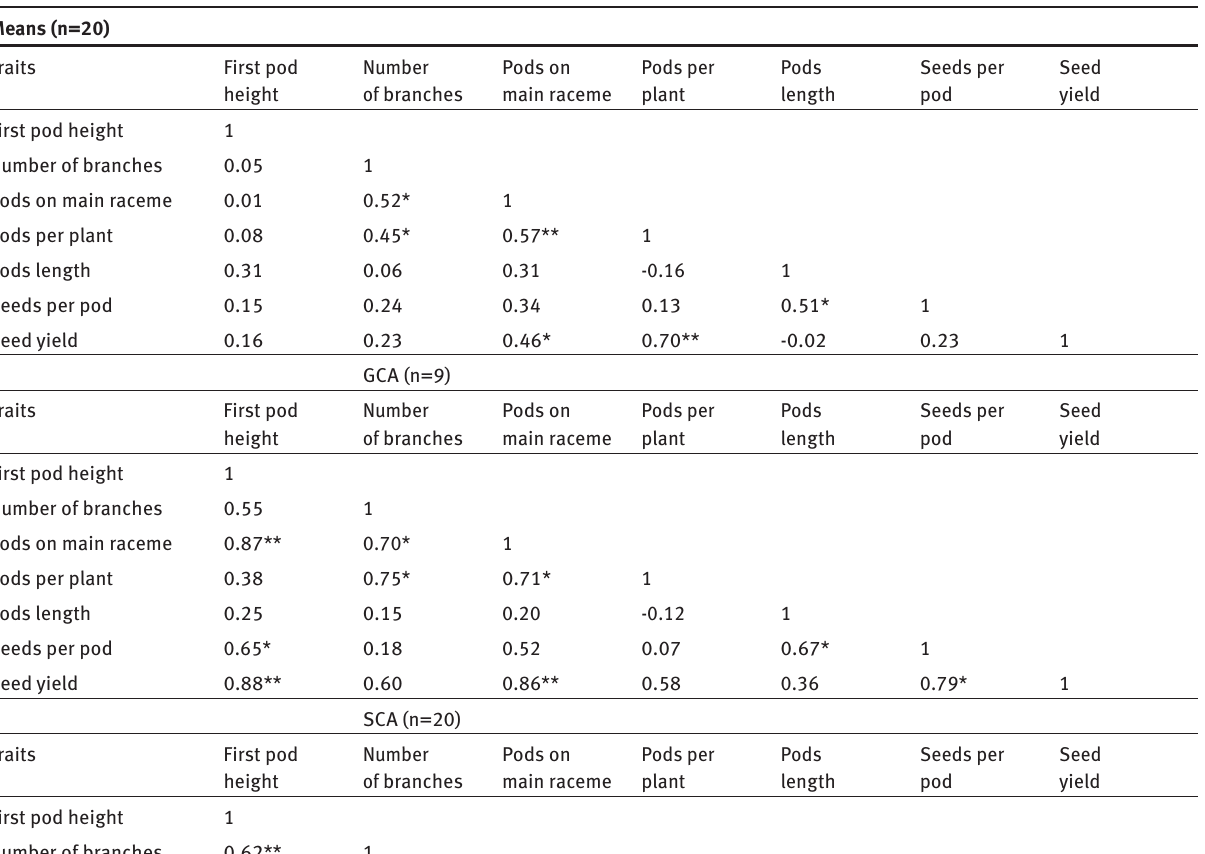
*/**Significant at p<0.05 and 0.01, respectively Table 4: Pearson coefficients of correlation estimates among the means, GCA effects of parent and SCA effects of the crosses for yield com- ponents and seed yield Means (n=20) Traits First pod height Number of